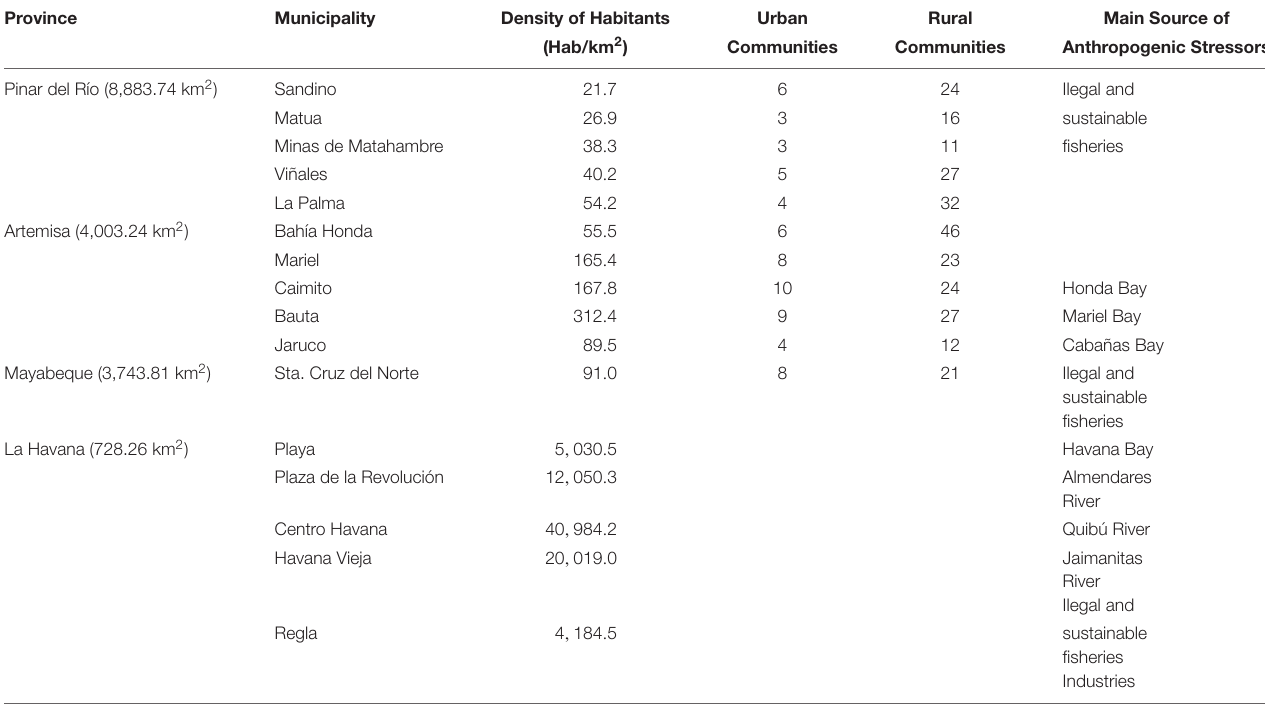
TABLE 2 | Population density in coastal municipalities (directly related with coral reefs), and main anthropogenic stressors in the northwestern Cuban provinces facing the Gulf of Mexico.